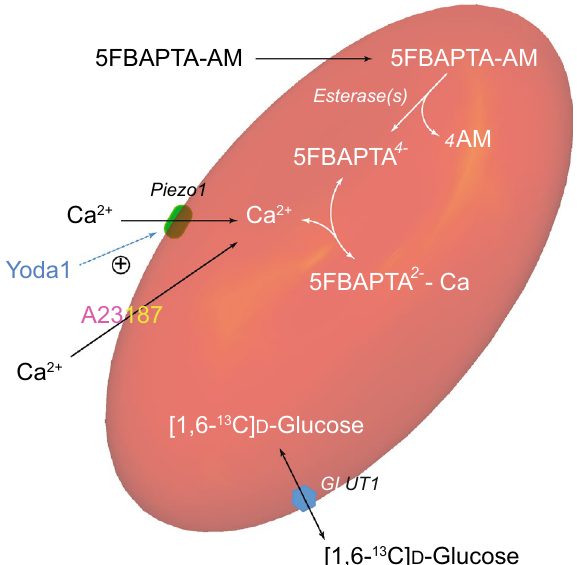
Figure 6. Graphical representation of an RBC under strain in a stretched gel (see below); it is loaded with the Ca 2+- sensing chelator 5FBAPTA that yields separate 19 F NMR signals from the free and Ca 2+ -complexed forms. Ca 2+ enters via the mechanosensitive cation channel Piezo1 that can be activated (+ symbol) by the small- molecule compound Yoda1. Ca 2+ entry into the RBC can also be mediated by the Ca 2+ -selective ionophore A23187. [1,6- 13 C]d-glucose enters the cell via the glucose transporter GLUT1; it was used in conjunction with 13 C NMR spectroscopy to measure glycolytic flux under various experimental conditions. The model of the distorted RBC is based on Cartesian translation in Mathematica 46 with the shape defined by the parametric equations given in 47